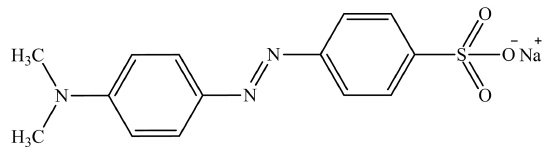
Figure 1. The chemical structure of methyl orange.